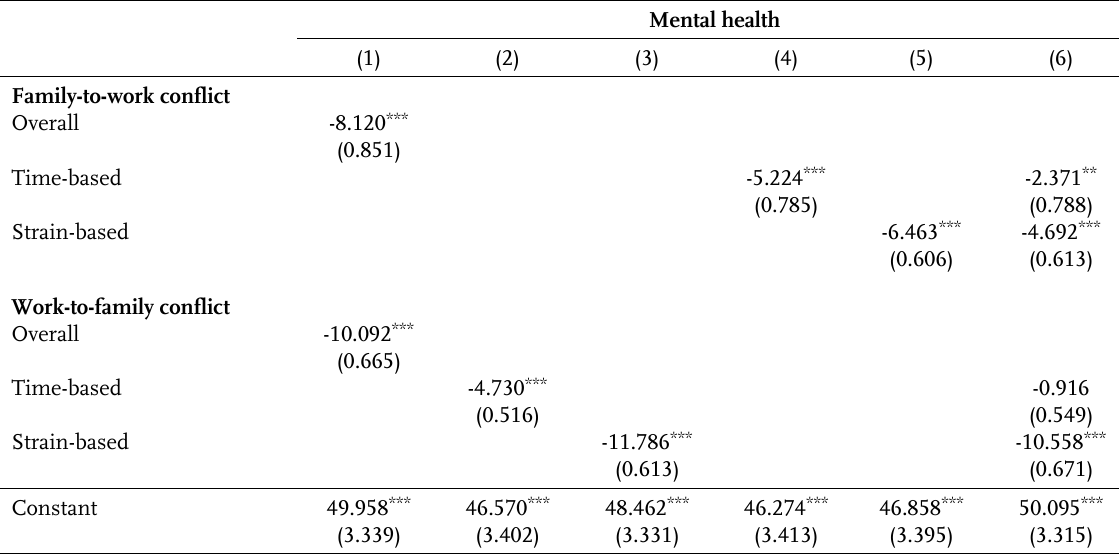
Table 2 : Linear fixed-effects regressions on mental health